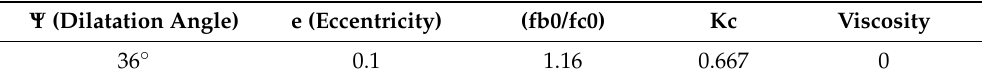
Table 3. Plasticity parameters.